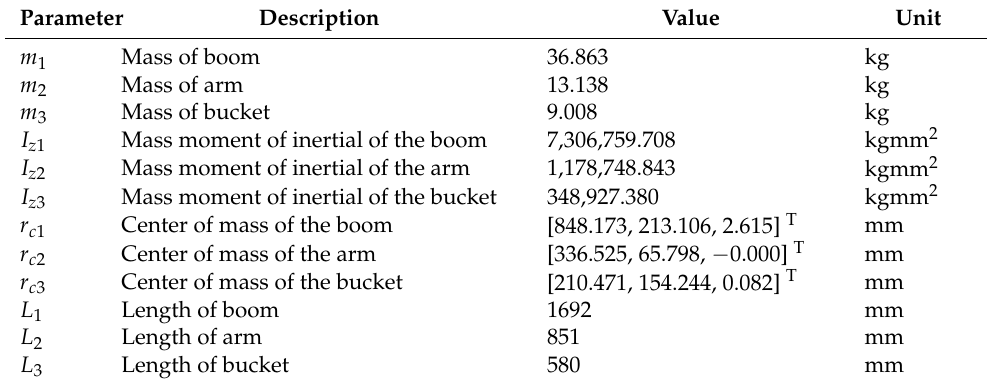
Table 1. Model parameter [4], Reprinted/adapted with permission from Ref. [4]. 2021, Elsevier.